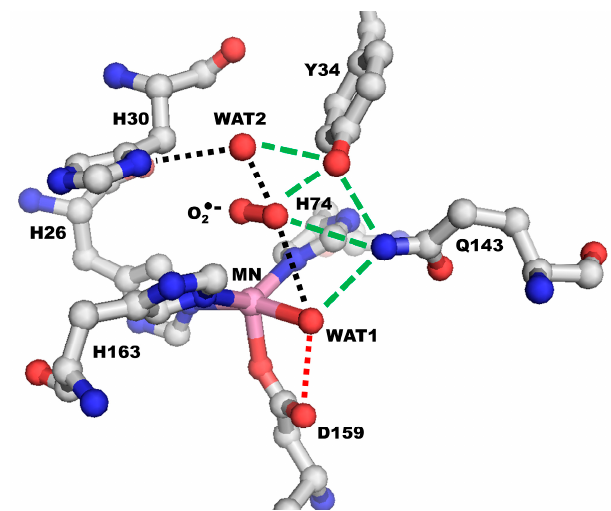
Figure 5. Putative superoxide-dependent proton shuttling mechanism. Black dashed lines indicate the proton transfer relay during catalysis. Red dashed line indicates the proton transfer from WAT1 to Asp159 that results in the inactive complex whereas the backwards transfer restores activity of the enzyme (model based on PDB entry 5T30). Green dashed lines indicate stabilizing hydrogen-bond interactions for molecules of the proton relay. Of note, superoxide is thought to bind Mn 3+ directly but not Mn 2+ , where it is instead bound to the active site solely through hydrogen bonding to members of the hydrogen-bond network. Single letter amino acid code is used.